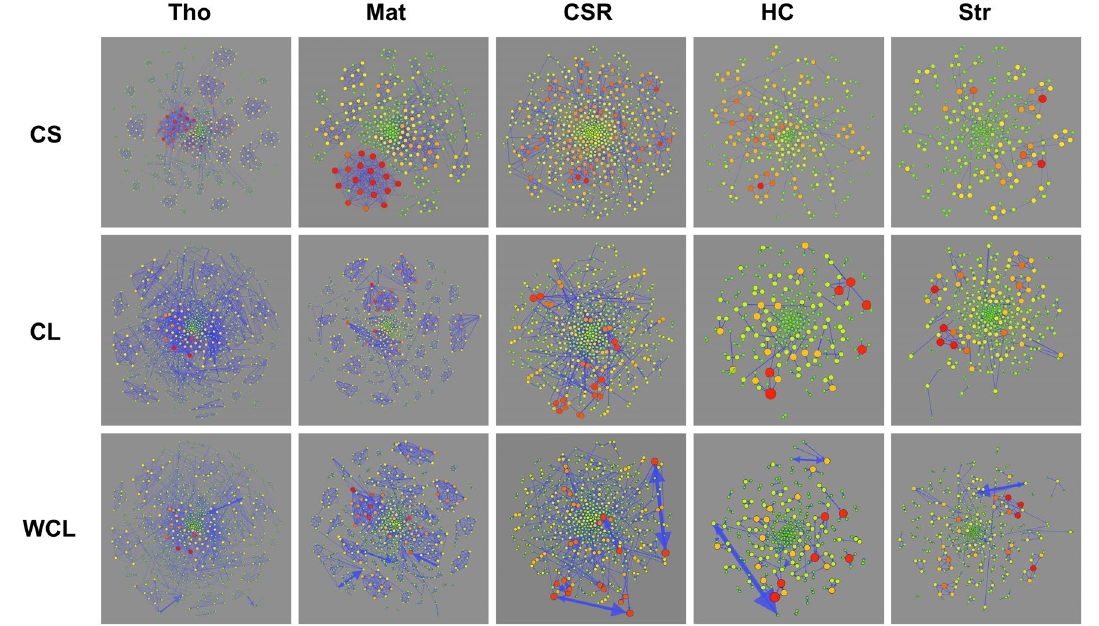
Figure 2. Three types of networks ( CS competition for space, CL competition for light, WCL weighted competition for light) for each spatial null model. Each node represents a tree, and each edge reflects competition. The size and color of the node reflect the degree of the node, the redder nodes have a greater degree. In WCL, the weight is proportional to the size of the edges. Arrow size reflects the intensity of asymmetric competition. The networks are drawn using Gephi 0.9.2 with a layout of